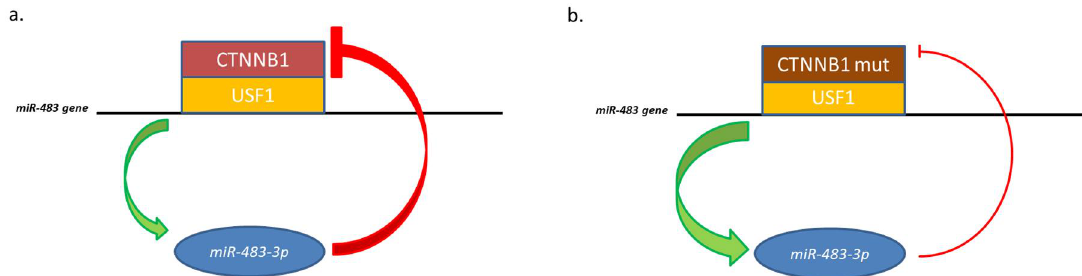
Figure 2. Representation of miR-483-3p feedback with the USF1/CTNNB1 complex. ( a ) Physiological negative feedback; ( b ) CTNNB1 mutated is no more regulated by miR-483-3p , which expression increase.